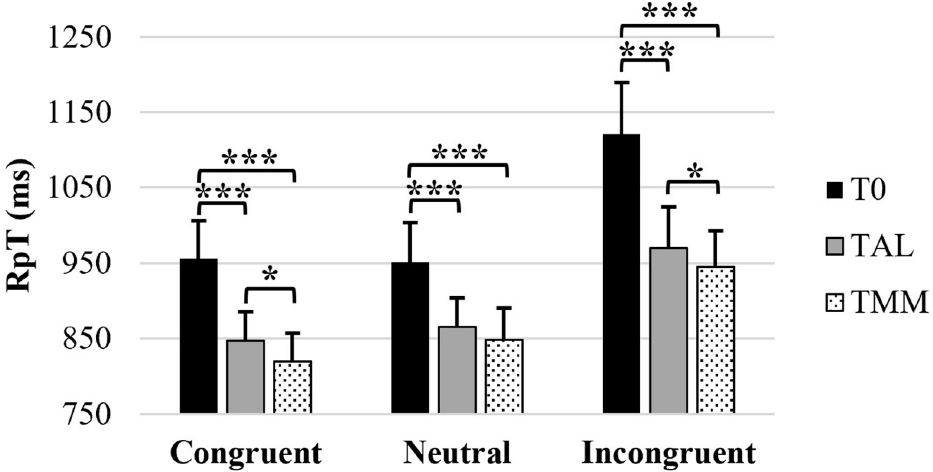
Fig 2. Stroop task mean reaction times (RT). Mean RT in milliseconds observed for successful trials for all participants (meditators and novices combined) across conditions. Error bars represent the normalized 95% confidence interval. Only the statistical significance of the decomposition of the condition × test interaction is represented. � p � 0.05 and ��� p � 0.001.